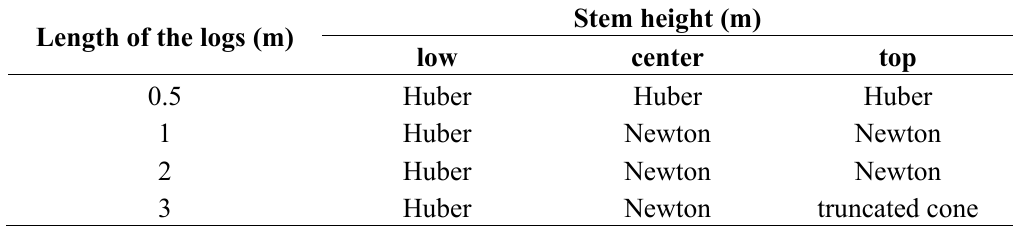
Table 6. Improved formula scaling according to the length of the logs and cutting